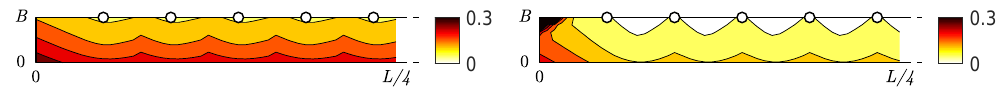
Figure 20. Maximum horizontal random measurement error of the static camera setup for (top) mono and (bottom) stereo setup for a quarter of the bridge deck. Colorbar expressed in meters.